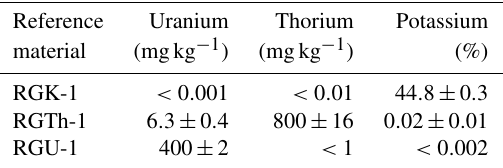
Table 2. Radionuclide concentrations as certified by the IAEA (IAEA, 1987). Uranium and thorium values are given in milligrams per kilogram (mgkg − 1 ), and potassium is given in percent. Uncer- tainties represent the 95% CI.